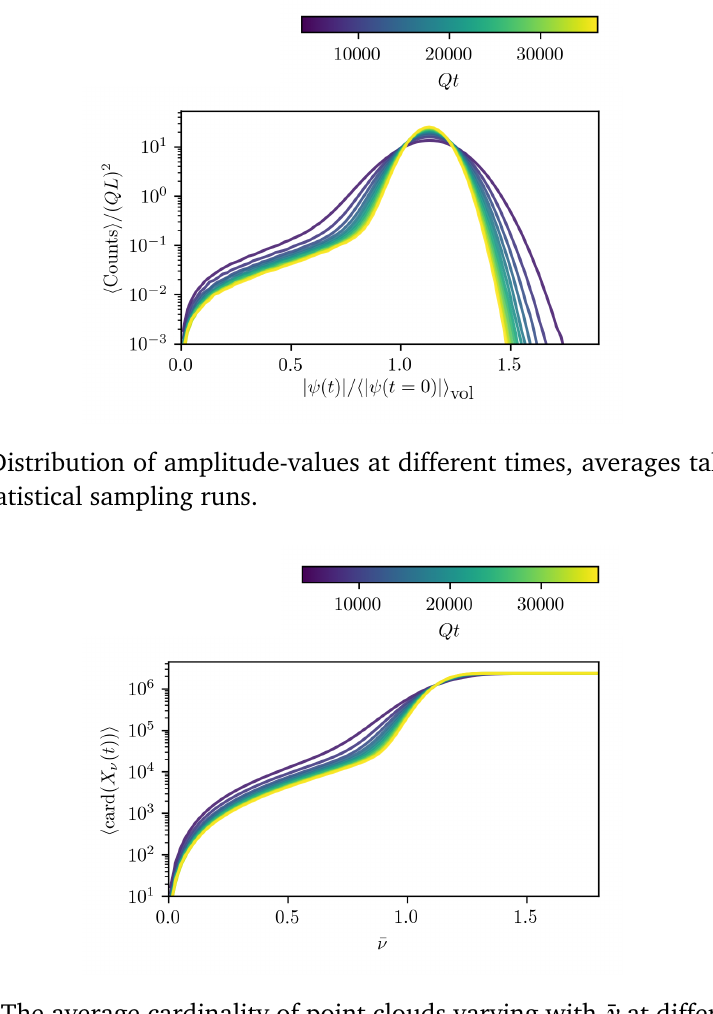
Figure 10: The average cardinality of point clouds varying with ¯ ν at different times, averages taken across classical-statistical sampling